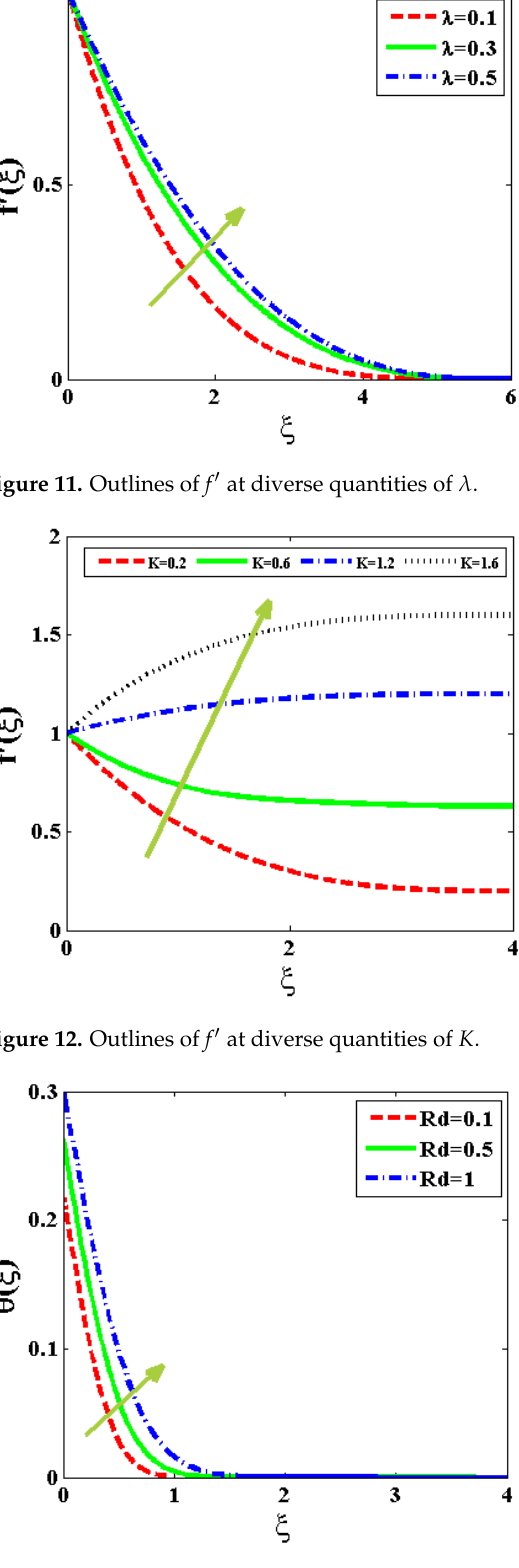
Figure 13. Outlines of 𝜃 at diverse quantities of 𝑅𝑑 .